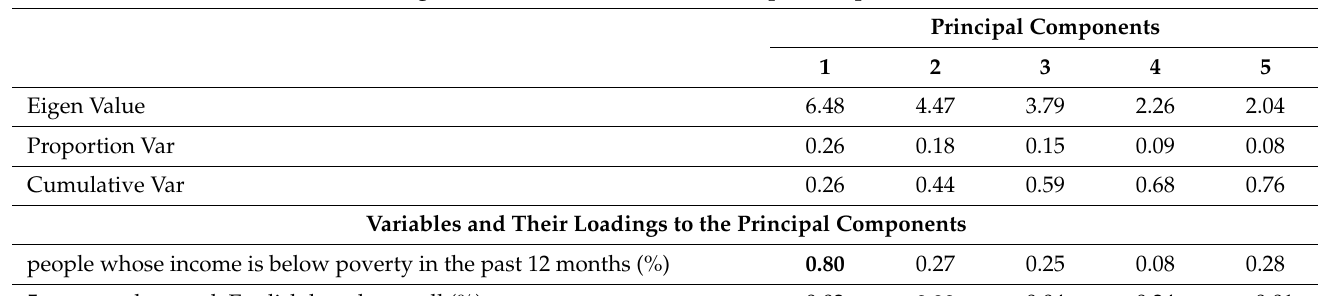
Table 1. The results of the PCA analysis on the census-tract level variables selected from 2015–2019 5-year American Community Survey and 2020 decennial census redistricting summary file (the bold loading values are the high loading of the variables used to characterize each principal